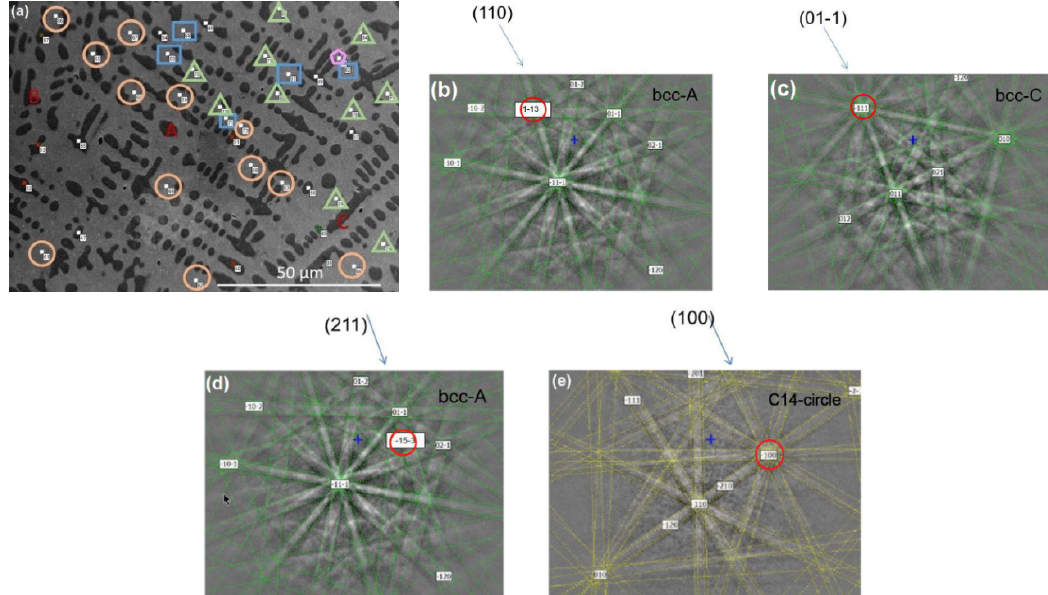
Figure 5. ( a ) The dark region, denoted as Phase I in the text, can be divided to Zones A–C (indicated by the red letters) based on the EBSD diffraction patterns. The light region, Phase II in the text, can be divided into four grains labeled by circles, triangles, rectangles, and pentagons (the numbers here are spot numbers in the measurement). Comparison between EBSD from ( b ) A and ( c ) C zones of the bcc phase indicates the following crystallographic orientation alignment: (110) A //(110) C and <311> A //<111> C . Comparison between EBSDs from ( d ) Zone A of the bcc phase and ( e ) the circle grain of the C14 phase indicates the following crystallographic orientation alignment: (211) A //(100) o and <153> A //<100> o . The circles in ( b – e ) highlight the aligned orientations.